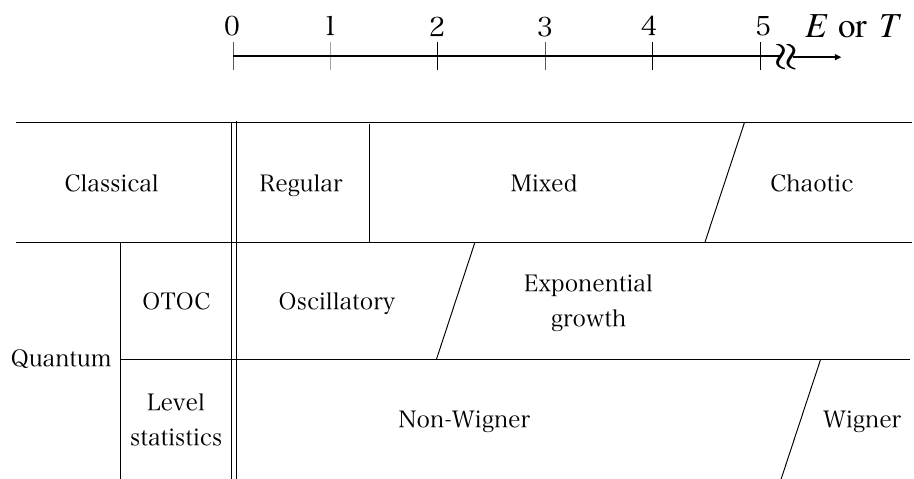
Figure 13 . Summary table of the energy (temperature) dependence of the classical/quantum chaos of the CHO system (1.1). The thermal OTOC can detect the quantum chaos at lower energy (temperature) compared with the level statistics. The quantum regular/chaos phase structure through the OTOC is found to be consistent with the classical phase structure, which indicates that the thermal OTOC properly re(cid:13)ects the property of the classical